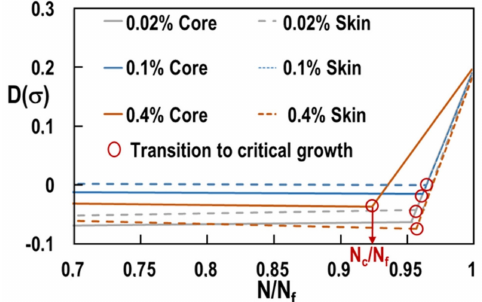
Figure 14. Damage D( σ ) as a function of the normalized number of cycles. Determination of the critical number of cycles NC corresponding to the transition from sub-critical to critical